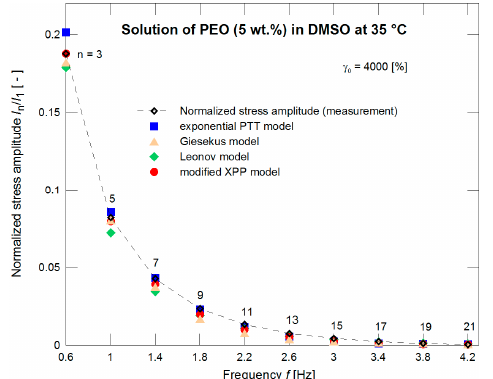
Figure 11. Optimization of the normalized stress amplitudes by the exponential PTT, Giesekus, Leonov, and modified XPP models for a strain of 4000%.